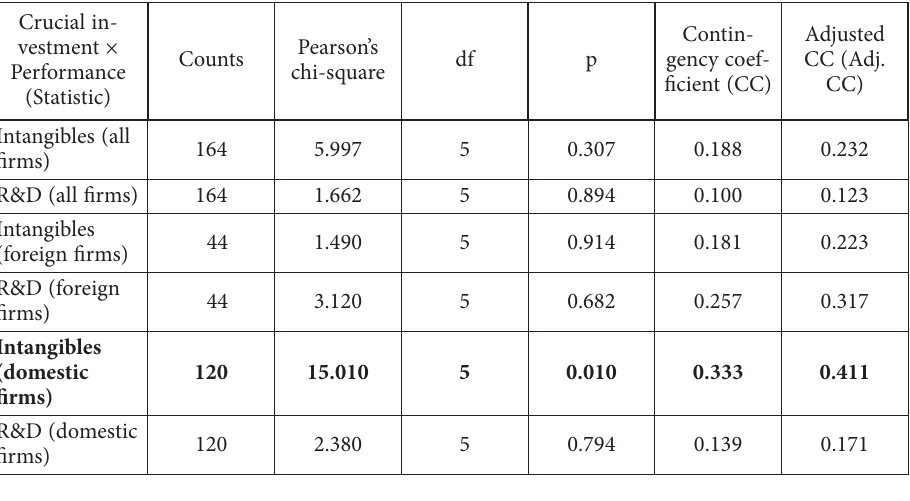
Table 11. Contingency: intangibles in domestic firms × performance – frequencies (source: own) Intangibles in domestic firms